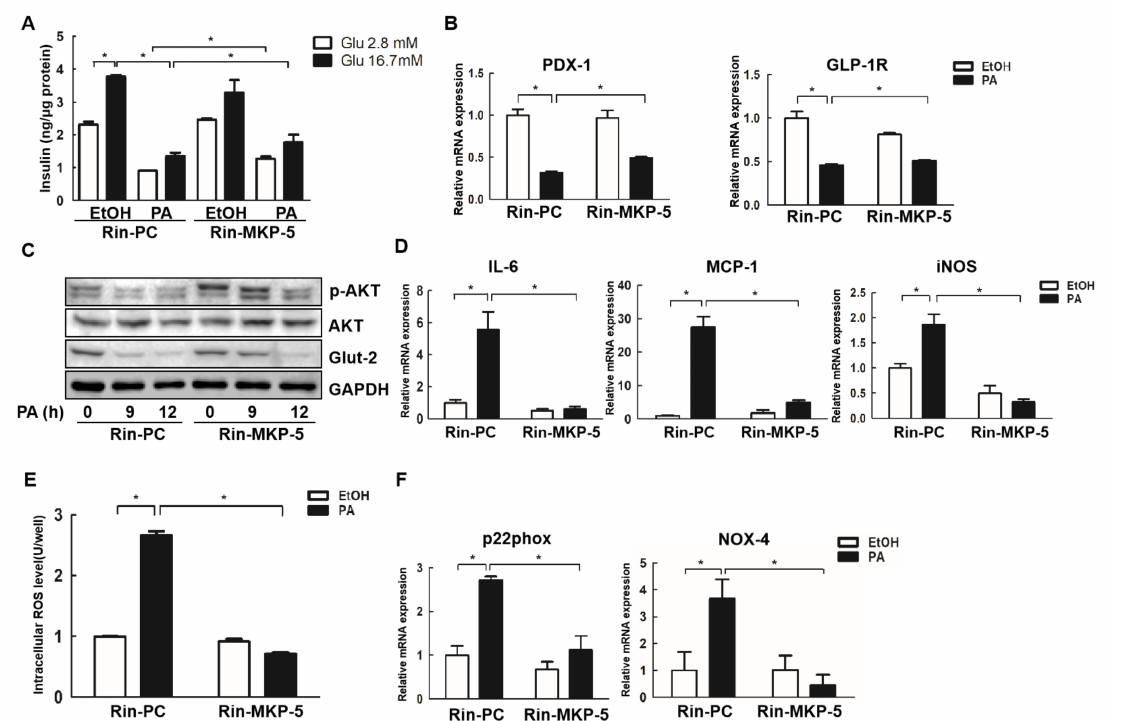
Figure 2. MKP-5 decreases inflammation, oxidative stress, and preserves the function of Rin-m5f cells in response to PA treatment. ( A ) Glucose-stimulated insulin secretion (GSIS) responses were determined by ELISA in Rin-MKP-5 and Rin-PC cells treated with PA for 24 h. ( B ) The relative mRNA expression of pancreatic duodenal homeobox factor-1 (PDX-1) and glucagon-like peptide-1 receptor (GLP-1R) were measured by real-time PCR in Rin-m5f cells upon 12 h PA treatment. ( C ) The protein levels of p-AKT, AKT, and Glut-2 were determined in Rin-PC and Rin-MKP-5 cells upon PA stimulation for 9 h and 12 h. ( D ) Expression of the inflammation-related genes inducible nitric oxide synthase (iNOS), interleukin-6 (IL-6), and monocyte chemotactic protein-1 (MCP-1) were detected by real-time PCR in Rin-m5f cells upon PA exposure for 12 h. ( E ) Levels of PA-induced intracellular reactive oxygen species (ROS) in Rin-PC and Rin-MKP-5 cells were determined using a fluorescence microplate reader by measuring DCFH-DA-fluorescence. ( F ) The expression of the ROS-related genes p22phox and NADPH oxidase-4 (Nox-4) was analyzed by real-time PCR. *, p < 0.05, EtOH vs. PA; Rin-PC vs. Rin-MKP-5; Glu 2.8 mM vs. Glu 16.7